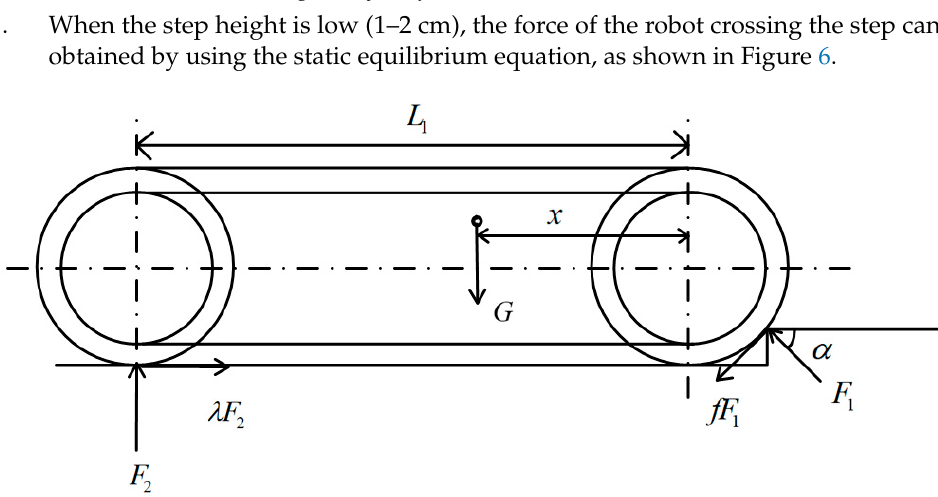
) , m 1 h m 1 + m 2 m 1 + m 2